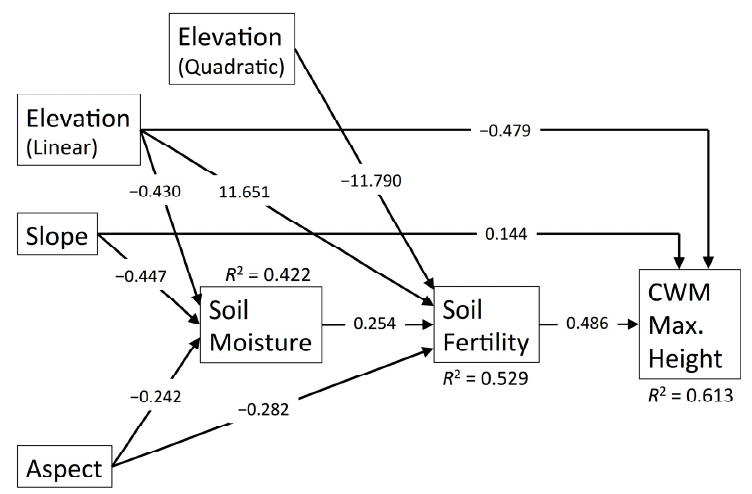
Figure 5. Path diagram for community-weighted mean maximum height. Standardized path coefficients are given. R 2 values are total explained variance.